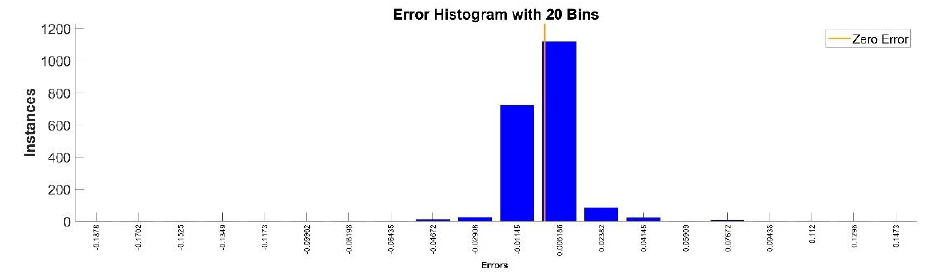
Figure 14. Error histogram between the target values and the estimated values for q 2 .